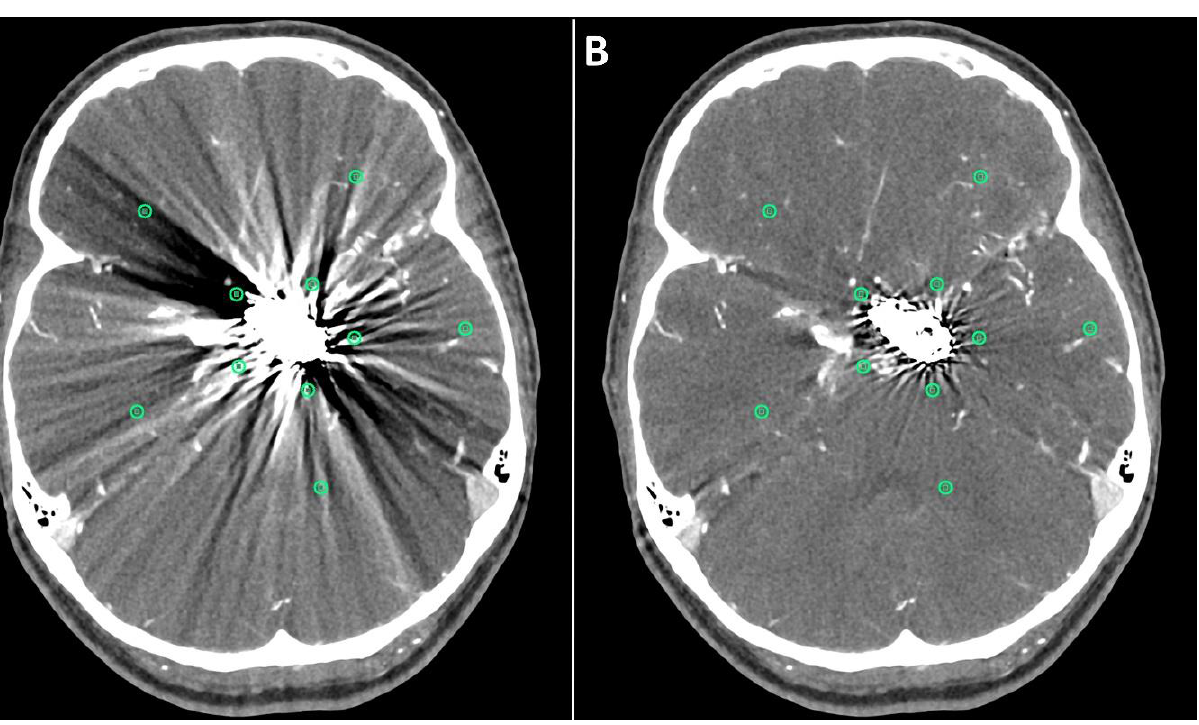
Figure 1. Positioning of ROIs (Region of Interest) for quantitative image analyses on standard ( A ) and SEMAR ( B ) CT-angiography images in axial plane (0.25 mm slice thickness) in direct proximity and more distally to the metal implant. In this case, follow up CT-angiography of a 56-year-old female who underwent coil-embolization of a left sided posterior communicating artery aneurysm.